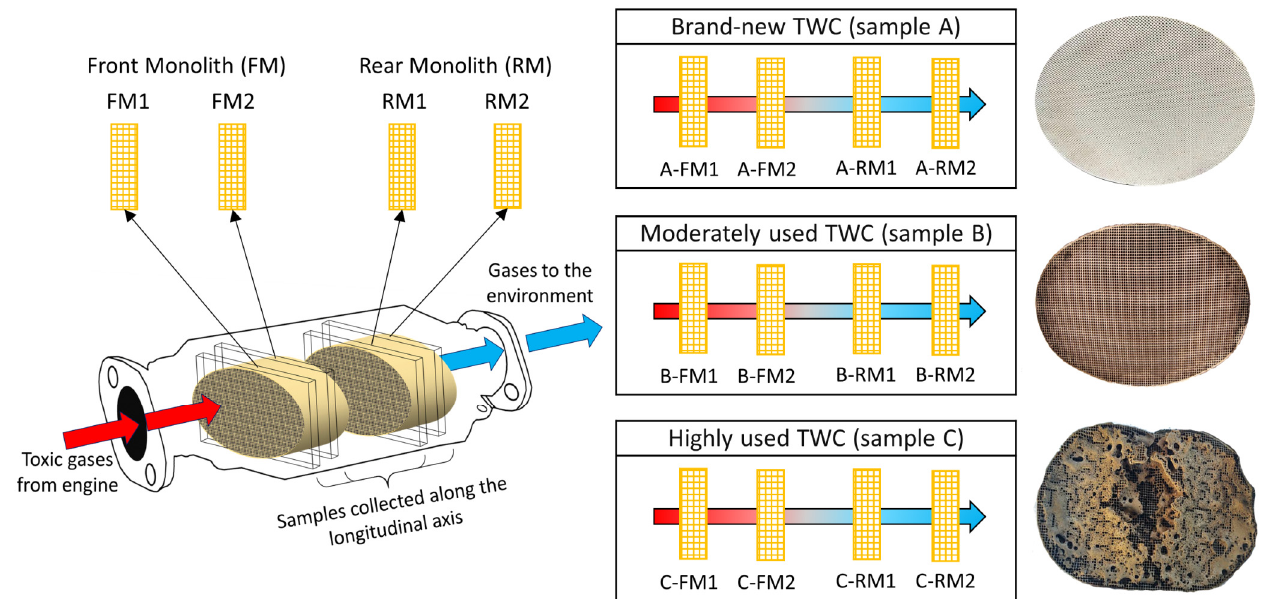
Figure 1. Scheme of the monolith sampling along the longitudinal axis. Labels for the four slices of TWCs were assigned from the front (FM1 and FM2) to the rear (RM1 and RM2). The gas flow direction coming from the engine is indicated with an arrow (red to blue).